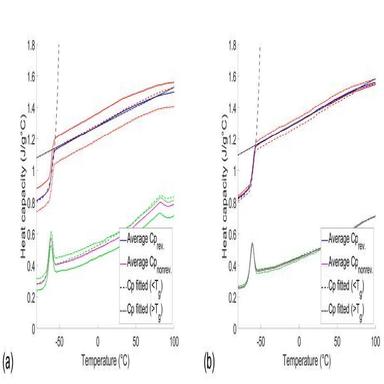
MDSC results for (a) F-NR2, (b) F-NR3 with model fits either side of Tg.